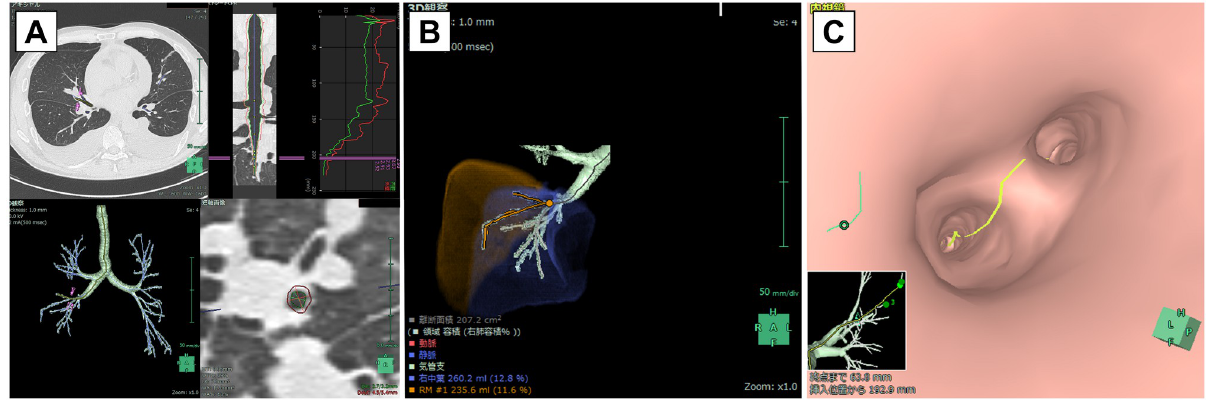
Fig 2. A 3D image analysis system using a SYNAPSE VINCENT volume analyser calculated the area of the bronchial wall and bronchial lumen based on the lung analysis (A), lung volume affiliated bronchus in which BAL was performed based on the lung resection analysis (B), and bifurcation numbers of bronchus based on bronchoscopy simulator